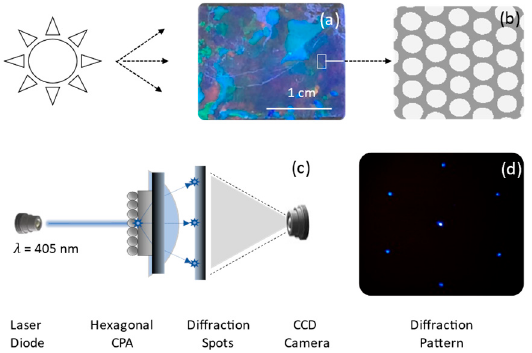
Figure 2. ( a ) Photograph of a CPA investigated under white light illumination to detect the existence of structural colors and ( b ) hexagonal ordering in the monolayer. ( c ) Schematic representation of the diffraction tool used for the inspection of CPA crystal quality. ( d ) Typical hexagonal diffraction pattern of the investigated